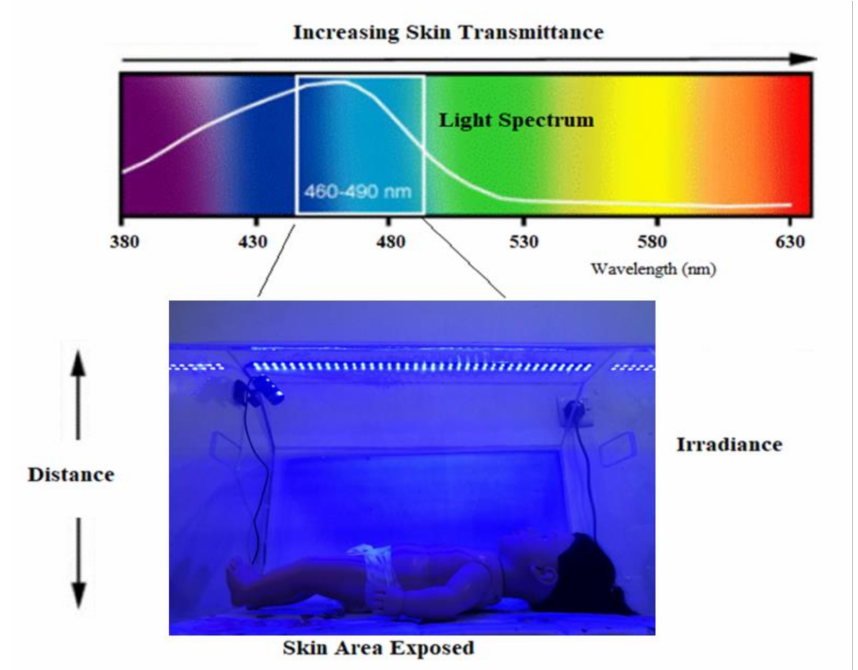
Figure 1. The effective range of wavelengths for